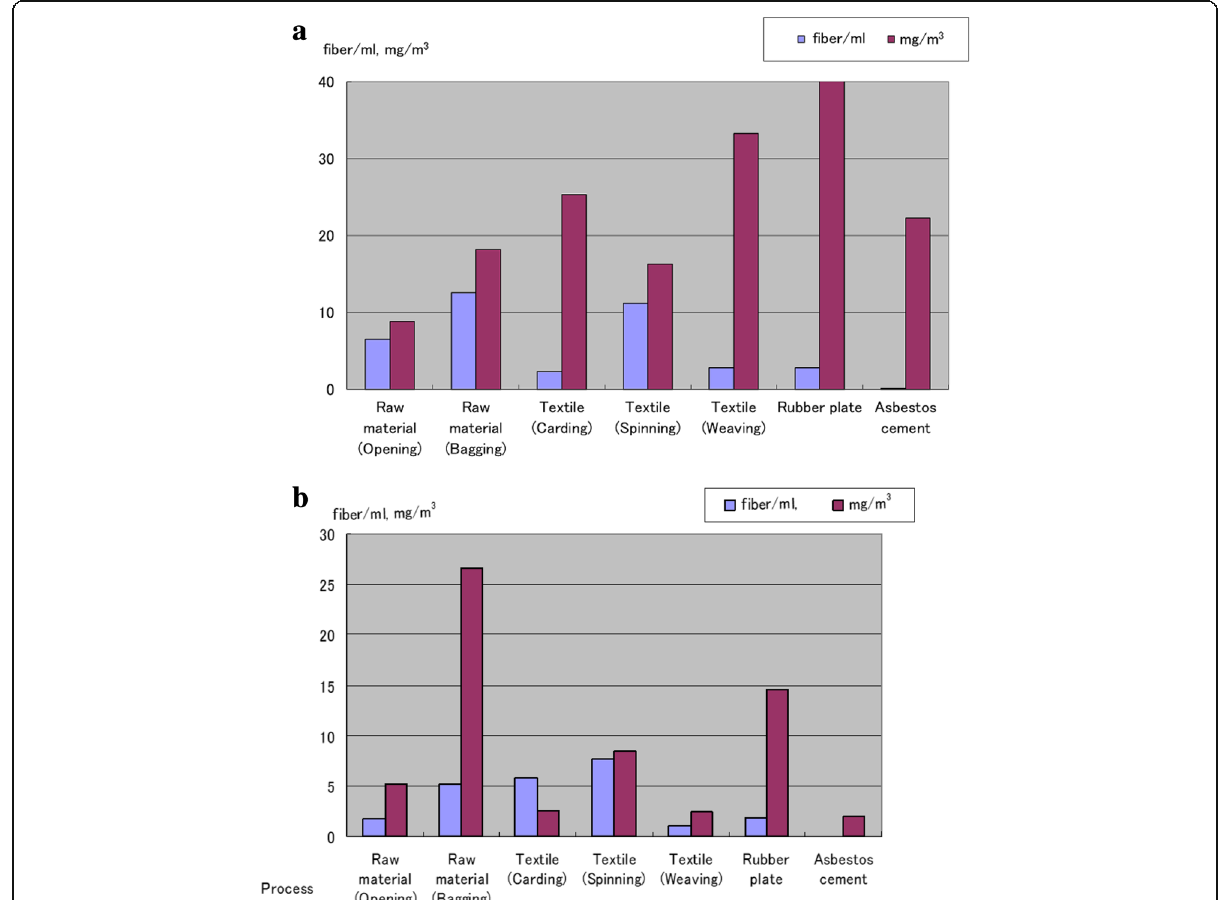
Fig. 4 a Dust and fiber concentrations obtained by personal sampling. b Dust and fiber concentrations obtained by workplace